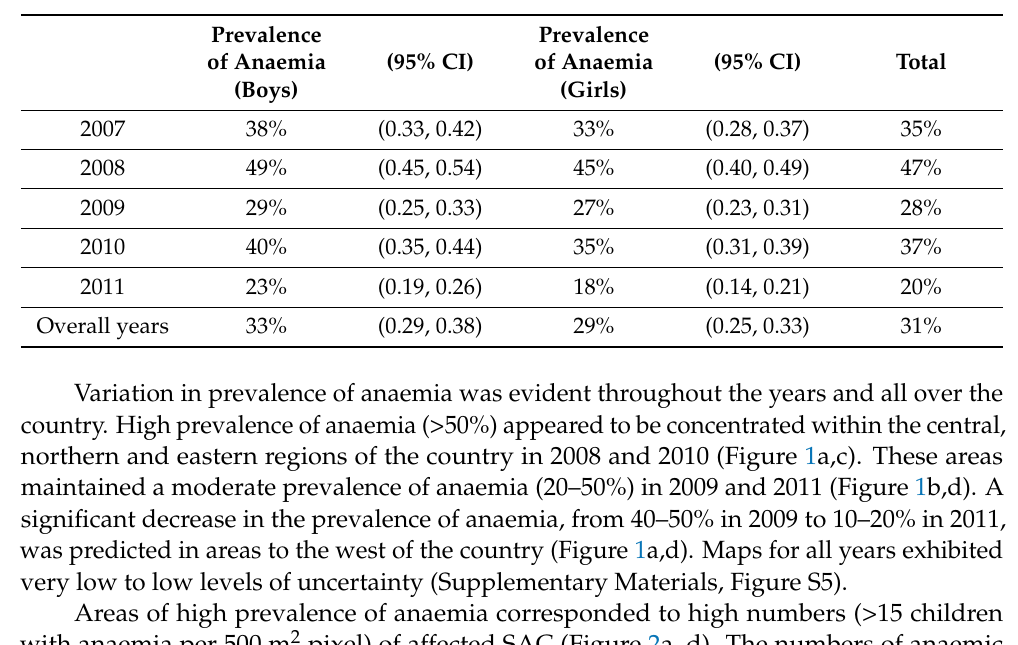
Table 4. Prevalence of anaemia for school-aged children in